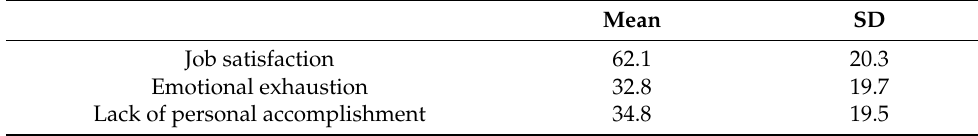
Table 6. Indices of job satisfaction and